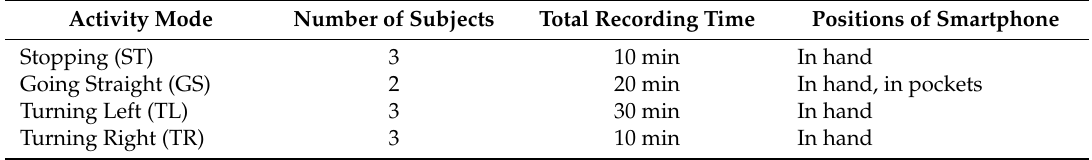
Table 9. Datasets for ADM.